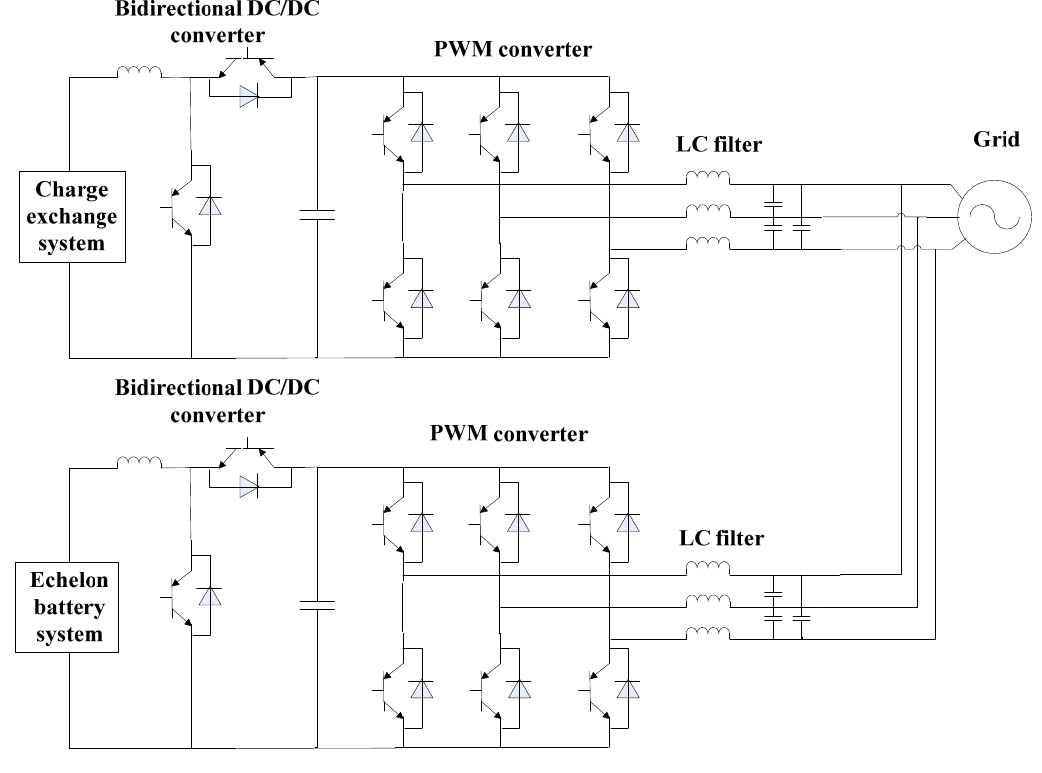
Figure 4. Multi-purpose converter